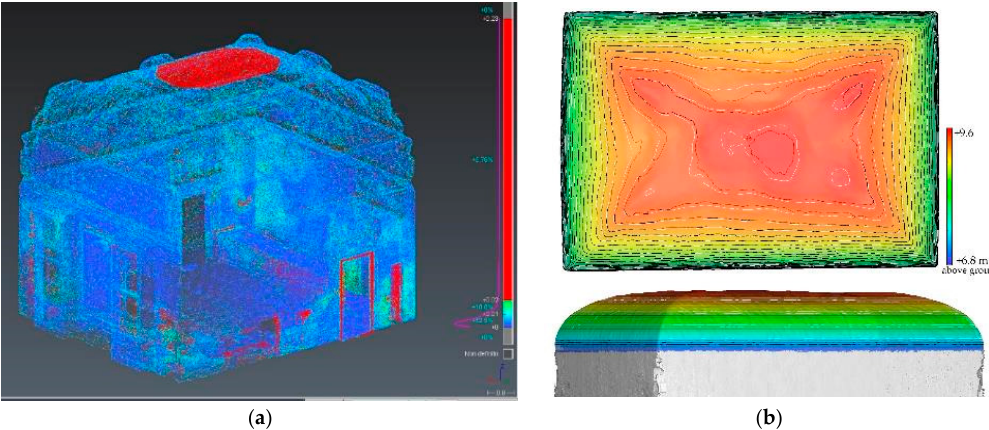
Figure 17. Morphological anomalies detected by the ZEB sensor: ( a ) the central part of the Fleur-de-lis Chamber vault in displacement map of T 2 –T 1 and ( b ) in the Great Salon vault, with the comparison of isolines from the LiDAR DSM (white) and ZEB (black).